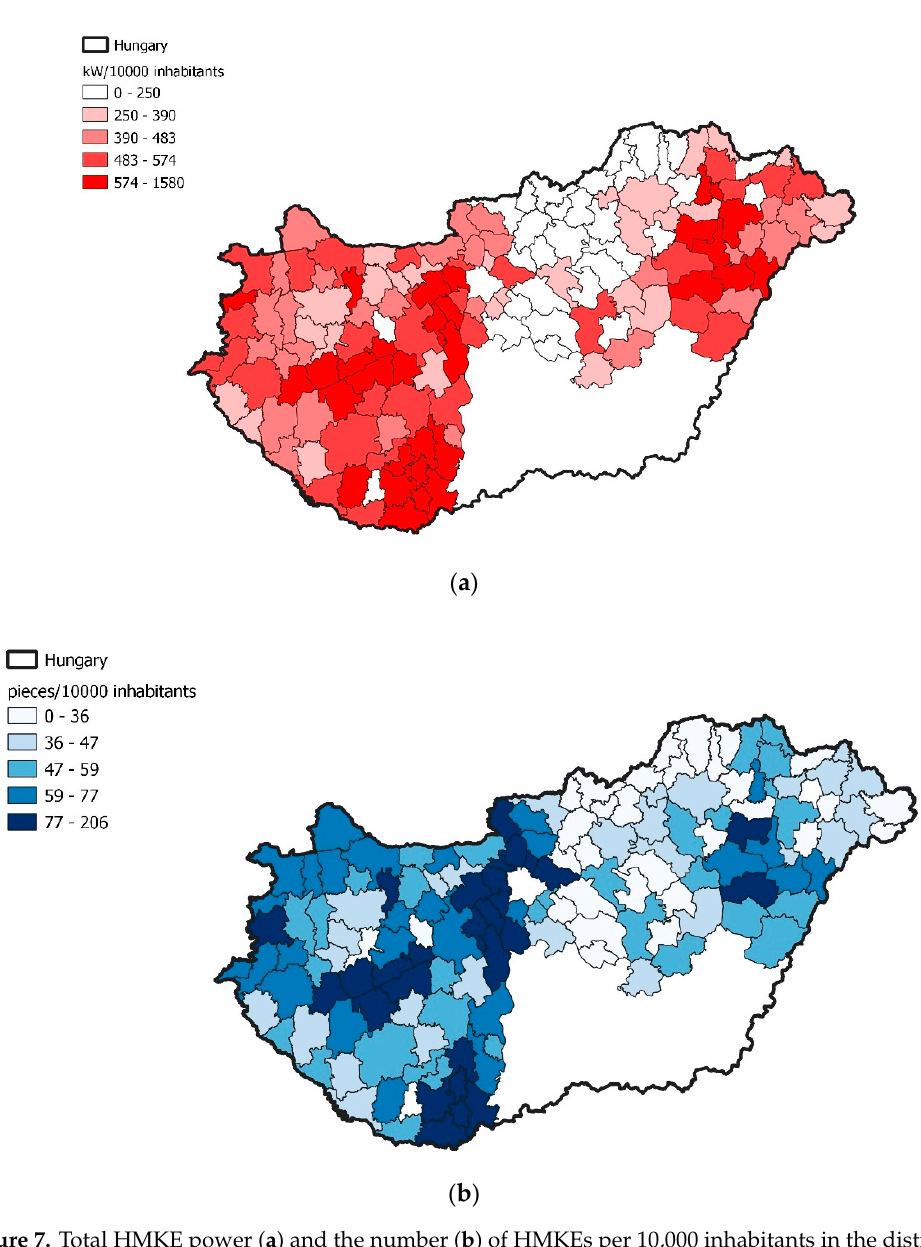
Figure 7. Total HMKE power ( a ) and the number ( b ) of HMKEs per 10,000 inhabitants in the districts of Hungary.